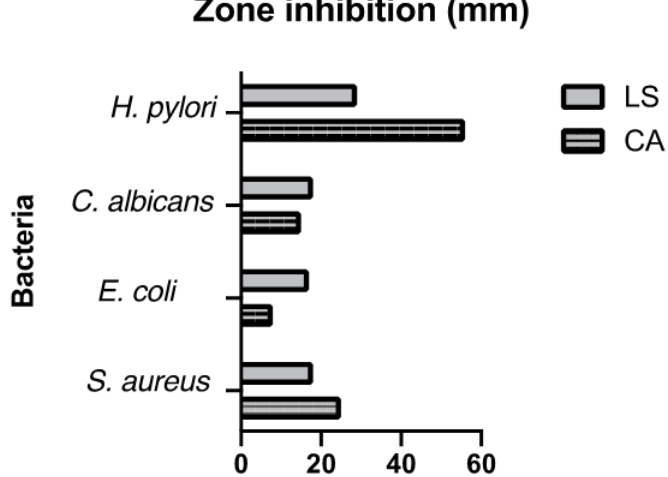
Figure 1. Zone of Inhibition (mm) resulting from CA ( Cryptocarya alba ) and LS ( Laurelia sempervirens ) EOs obtained by hydrodistillation in a Clevenger-type apparatus.